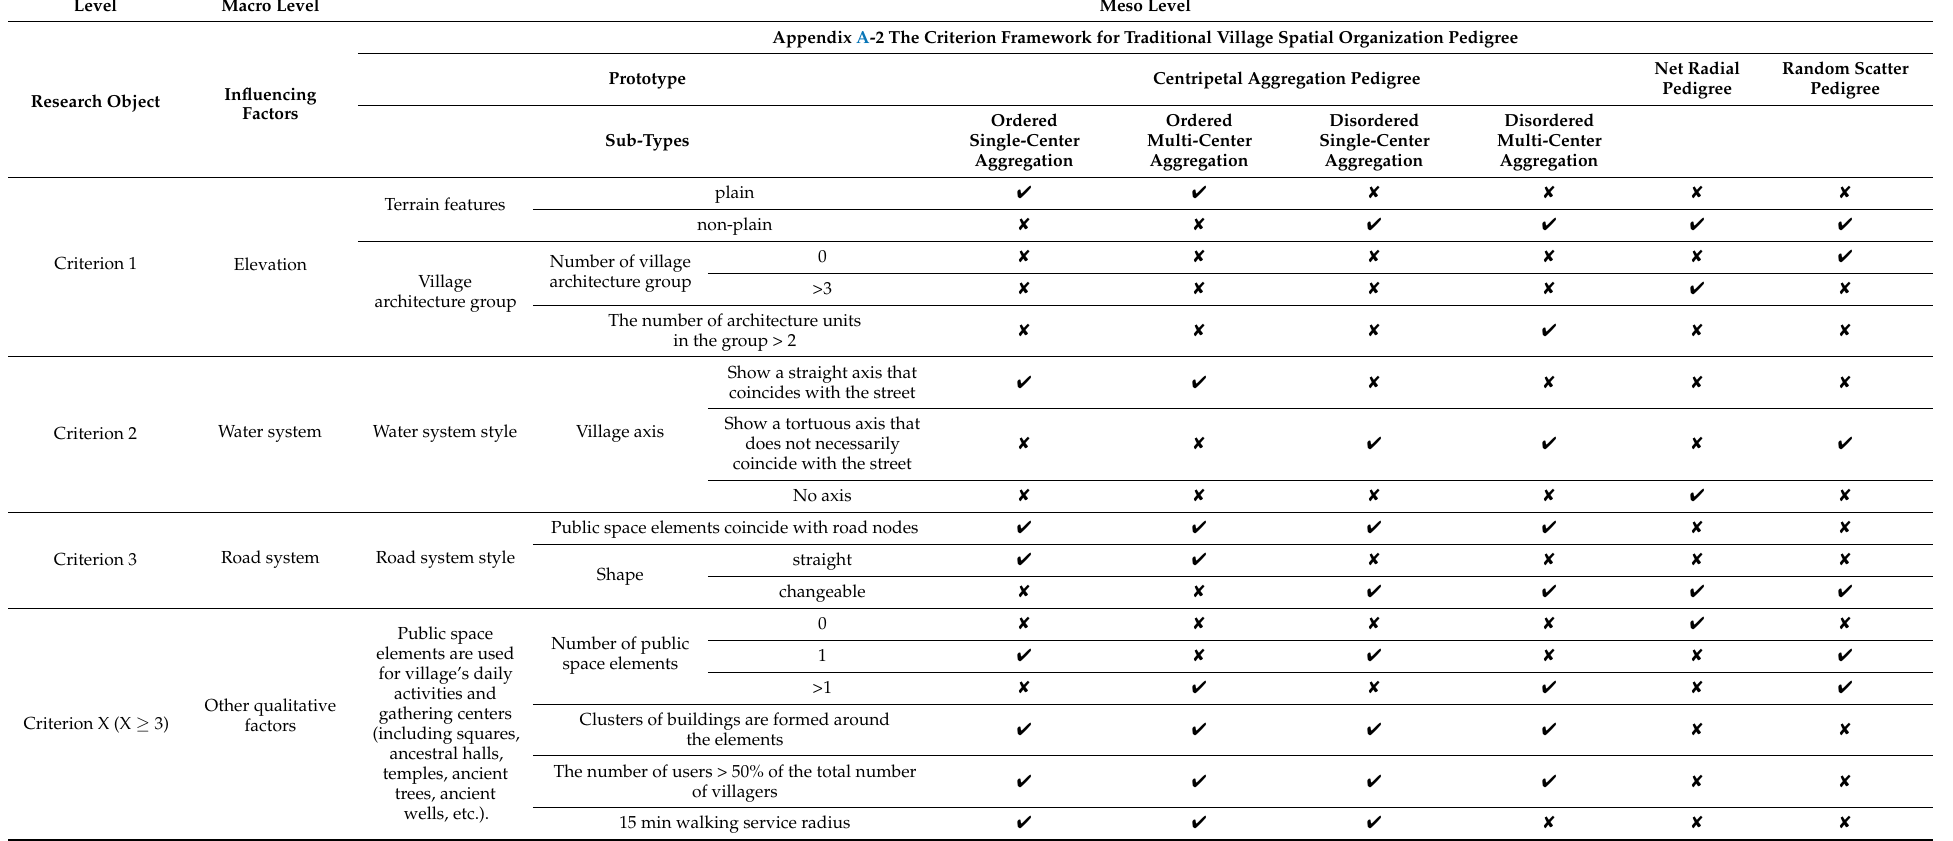
Table A3. The Criterion Framework for Traditional Village Spatial Organization Pedigree: Edited by